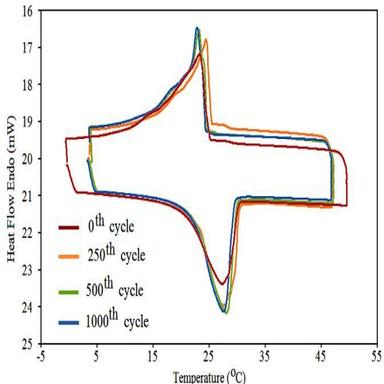
DSC curves of Sep/FAEM(42 wt%) after 250, 500 and 1000 cycles.